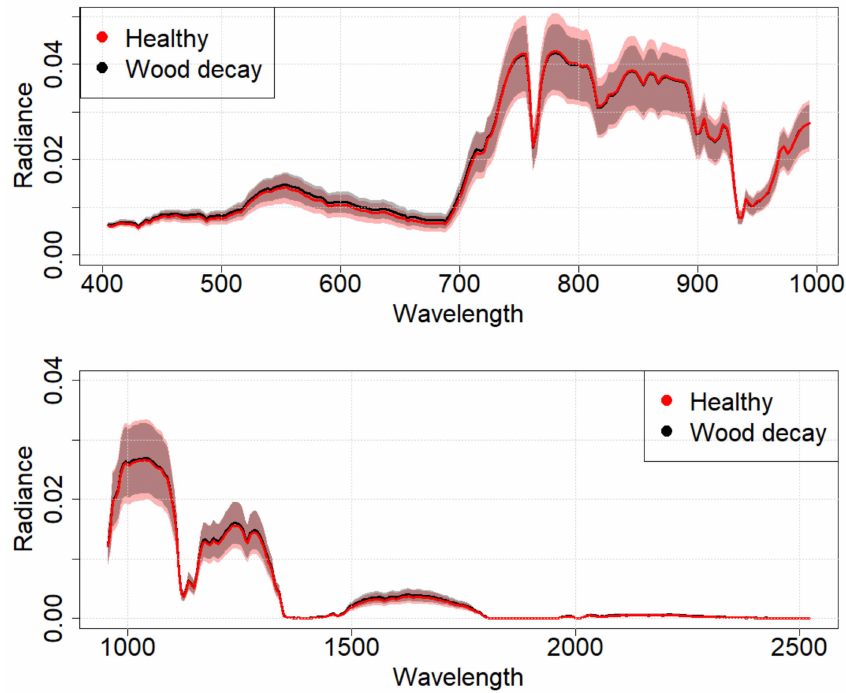
Figure 4. Spectral signatures of the healthy and wood decay ITCs in the Etnedal dataset using the mean pixel aggregations. The continuous line represents the median spectral signature while the box shows a range from the 25th to the 75th